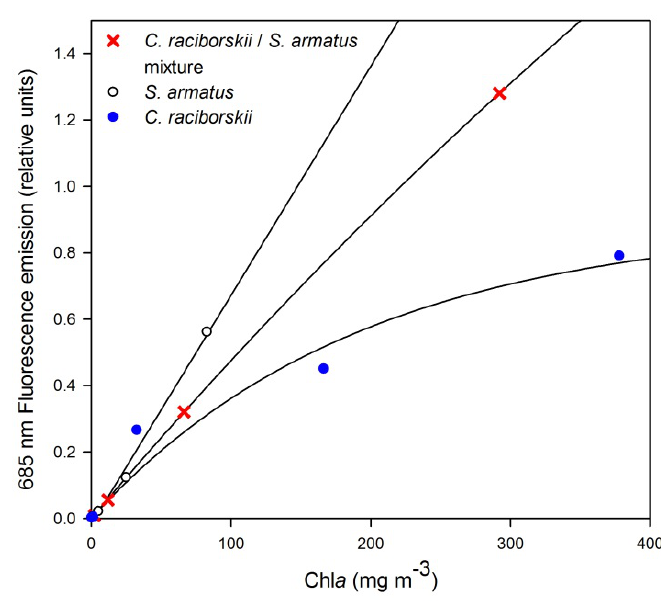
Figure 4. Distinct relationships between chl a concentration and fluorescence emission at 685 nm (excitation laser pulse wavelength = 355 nm) for Cylindrospermopsis raciborskii (chl a = 0.897 × (1 − exp( − 0.005 × UFL ); R = 0.98; p < 0.005; n = 5), Scenedesmus 685 armatus (chl a = 0.007 × UFL − 0.018; R = 0.99; p < 0.004; n = 4), and a mixture of the 685 ); R = 0.99; p < 0.001; n = 4). two (chl a = 5.71 × (1 − exp( − 0.001 × UFL 685